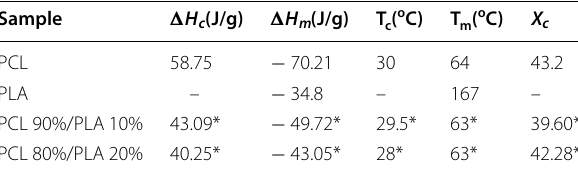
* These values are for PCL of the blends